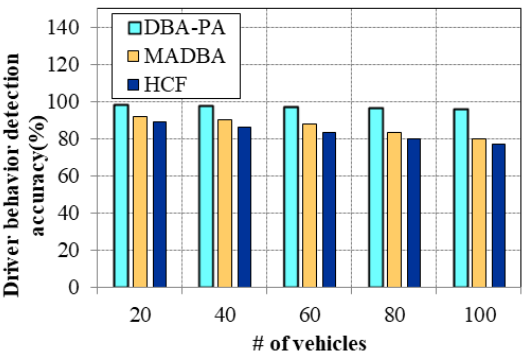
Figure 9. Number of Vehicles vs. Driver-Behavior Detection Accuracy.